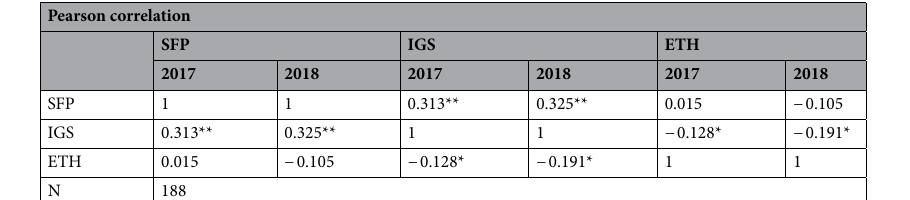
Table 2. Correlation among spikelet fertility percentage (SFP), inter-grain space (IGS) and ethylene production (ETH) in 188 RILs developed from the cross between PDK Shriram (HGN) and Heera grown during kharif seasons of 2017 and 2018. **Correlation is significant at the 0.01 level (1-tailed). *Correlation is significant at the 0.05 level (1-tailed).